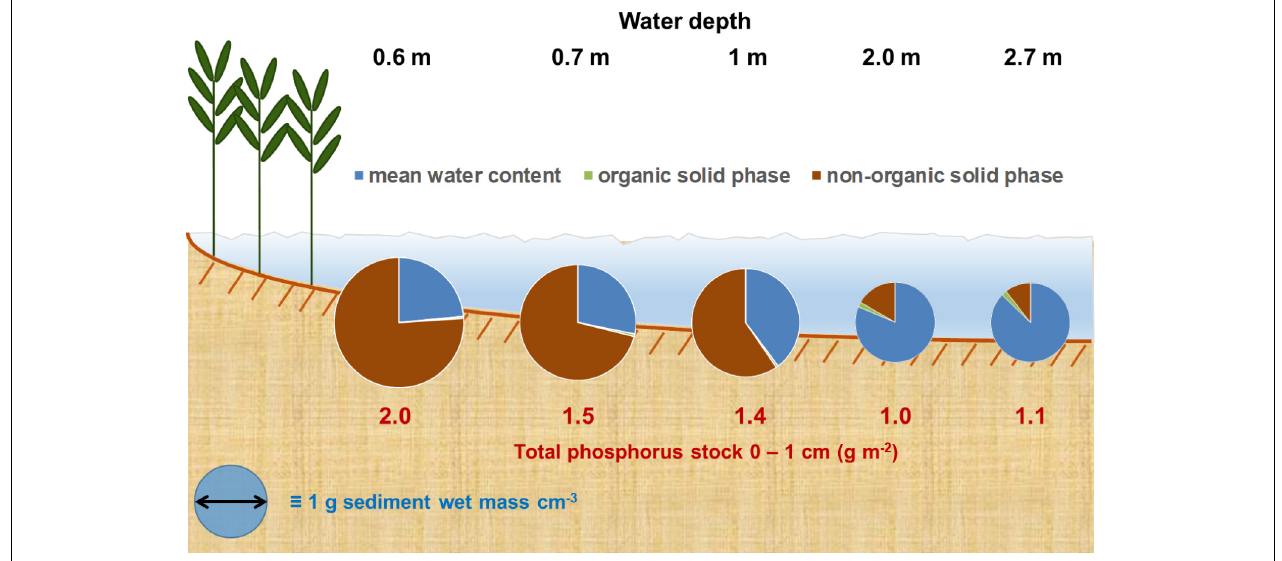
FIGURE 7 | Graphical summary of sediment properties development along the exemplary transect in the Grabow. Sediments wet bulk density is direct proportional to the circle’s diameter. Organic solid phase was calculated as share of the whole solid phase per wet sediment volume.